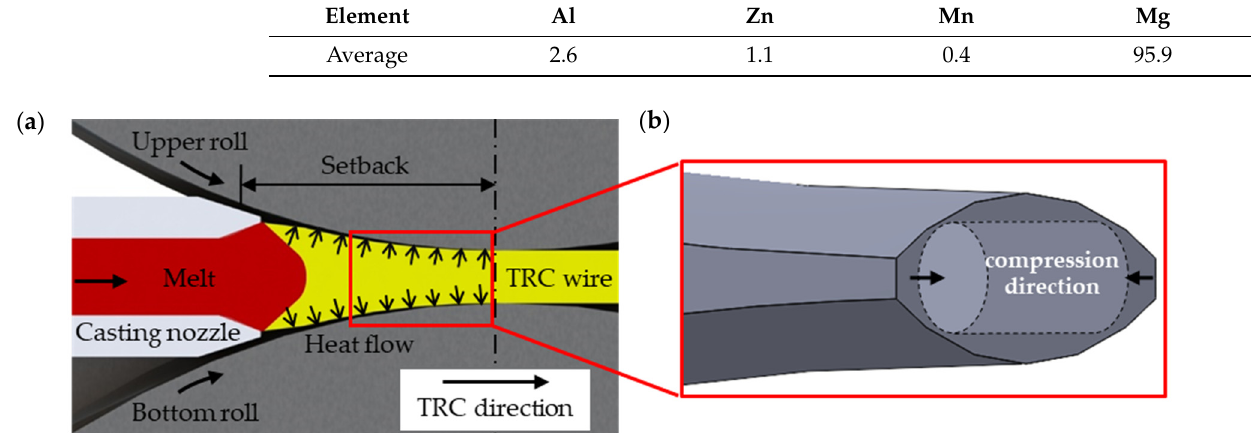
Figure 1. ( a ) Principle of the twin-roll casting process [7], ( b ) sample collection from wire pre-profile for compression test at quenching and forming dilatometer. Table 1. Chemical composition of the AZ31 ingots in wt.% [9].